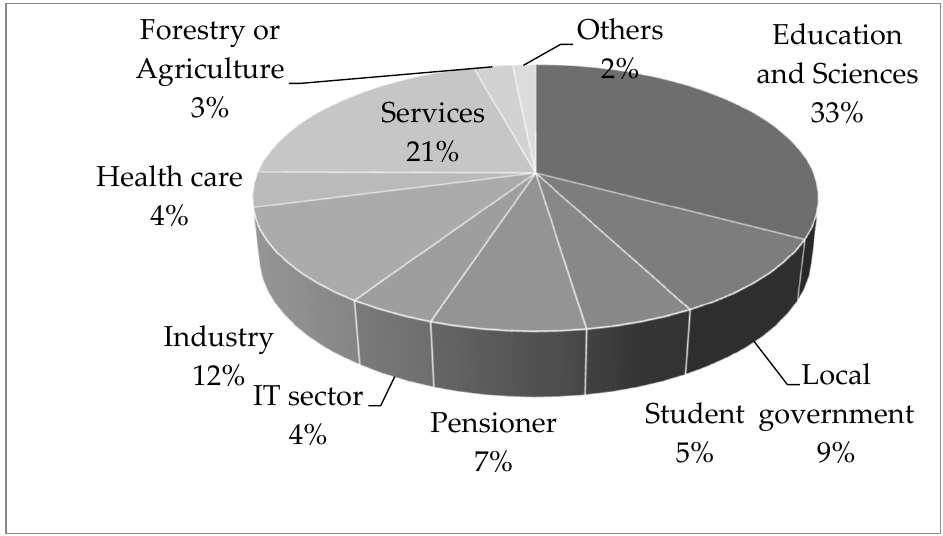
Figure 2. Respondent structure according to employment.